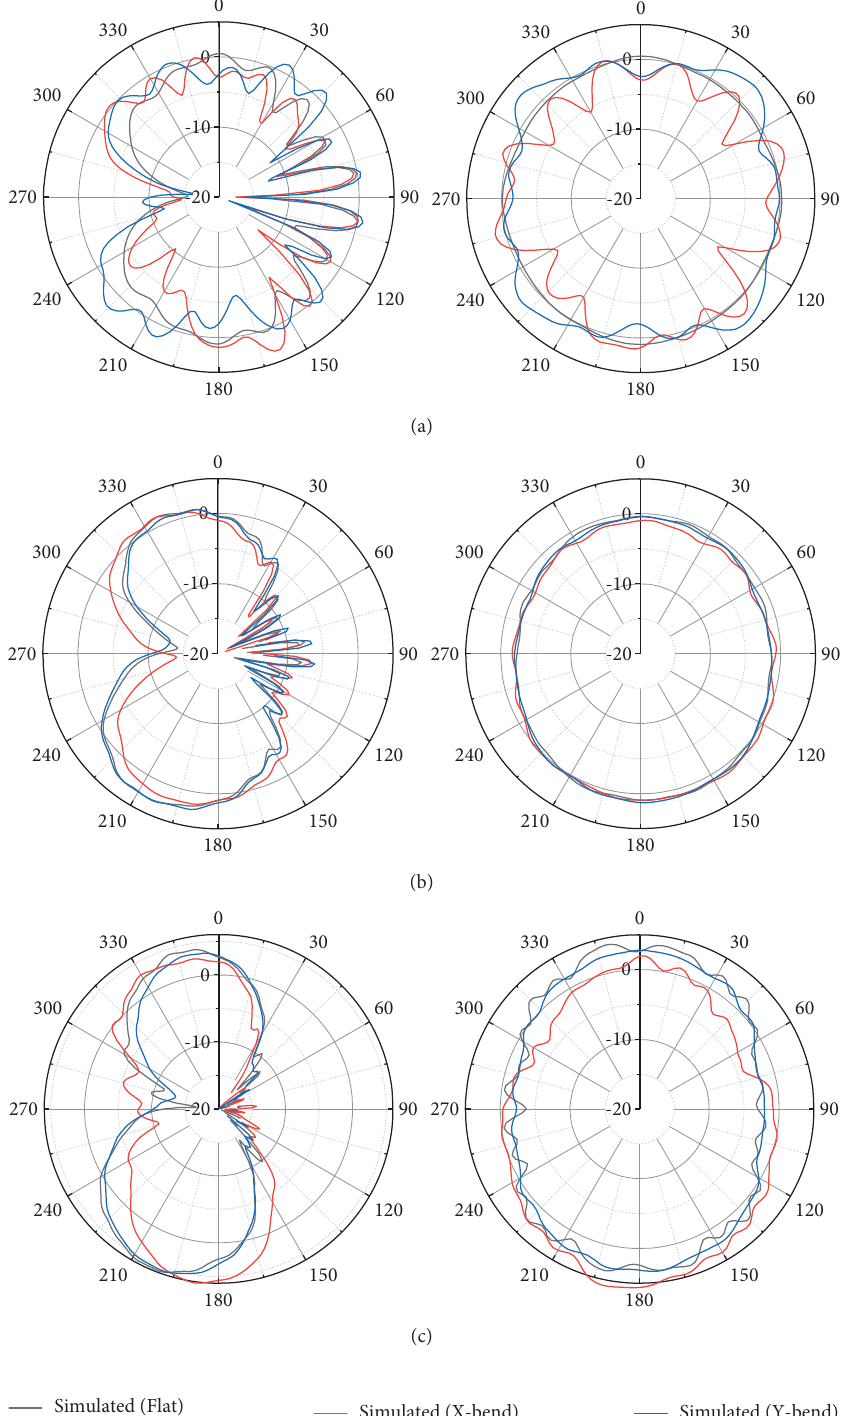
Figure 14: Comparison of simulated radiation patterns on the human head due to deformation of different structures in the YOZ-plane and XOZ-plane. (a) 4GHz. (b) 6GHz. (c) 8